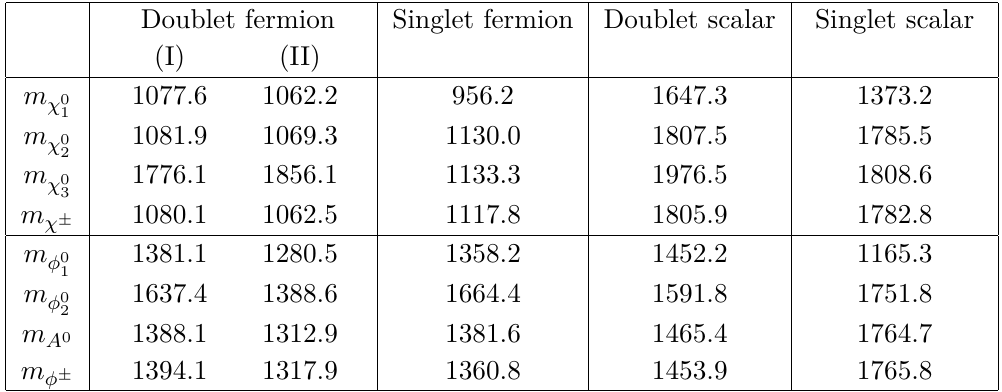
Table 6 . Typical phenomenologically viable mass configurations in the T1-2A scotogenic model resulting from our Markov Chain Monte Carlo analysis. We indicate the physical masses of the new fermions and scalars for the five chosen dark matter configurations. All masses are given in